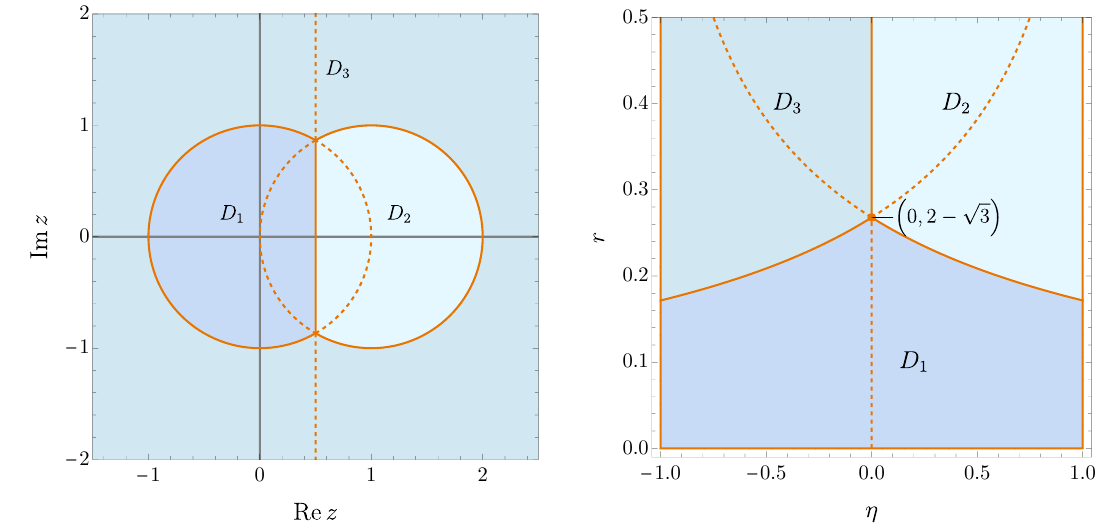
Figure 4 . The fundamental domains under the S 3 crossing symmetry in z, ¯ z ( left ) and r, η coordinates ( right ). Dotted lines denote the boundaries between individual fundamental domains, and solid lines denote the boundaries between the unions of domains D 1 , D 2 , and D 3 discussed in the text. The s -channel block expansion converges in D 1